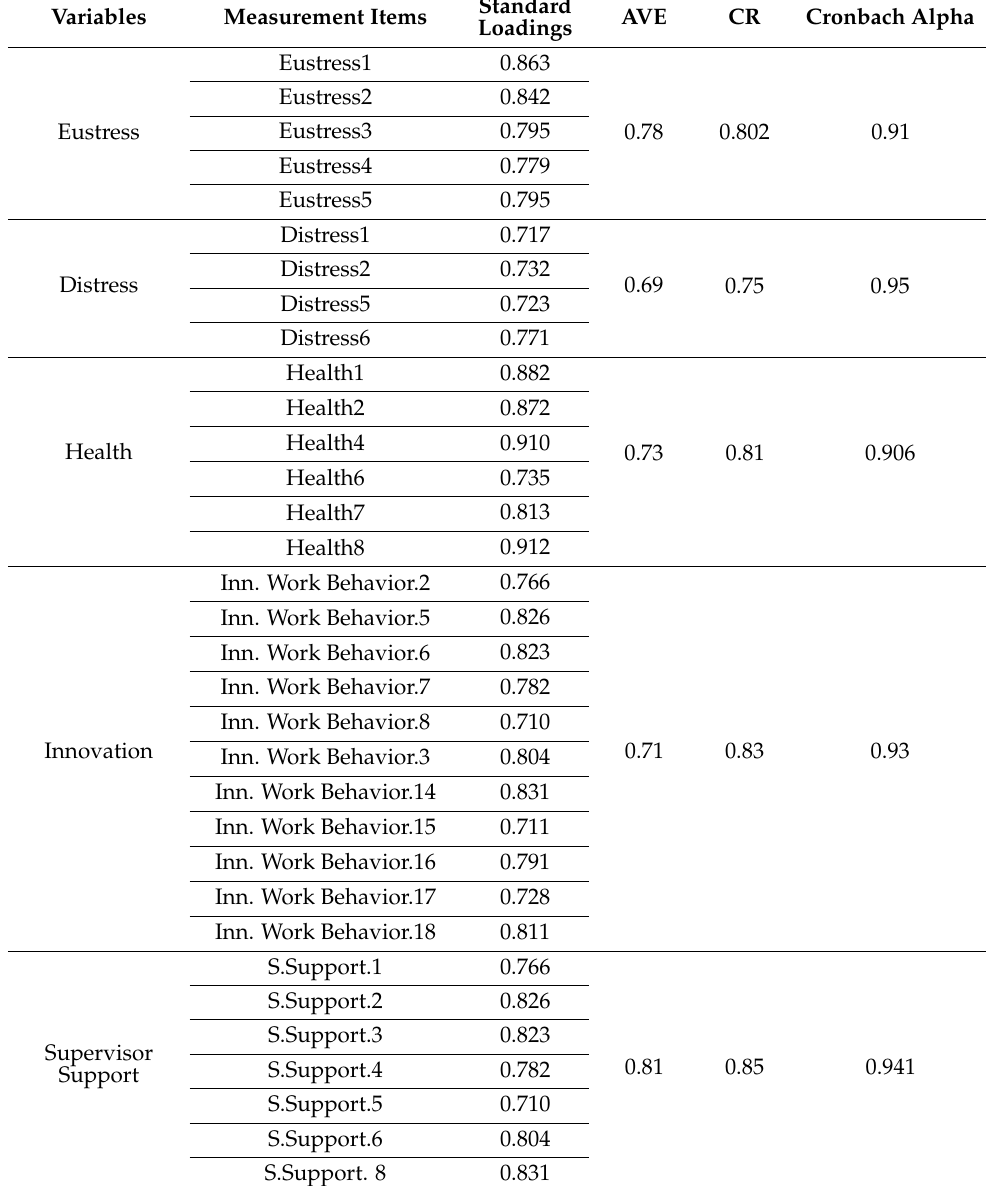
Table 5. Average variance extracted, Composite reliability, and collective Cronbach Alpha.